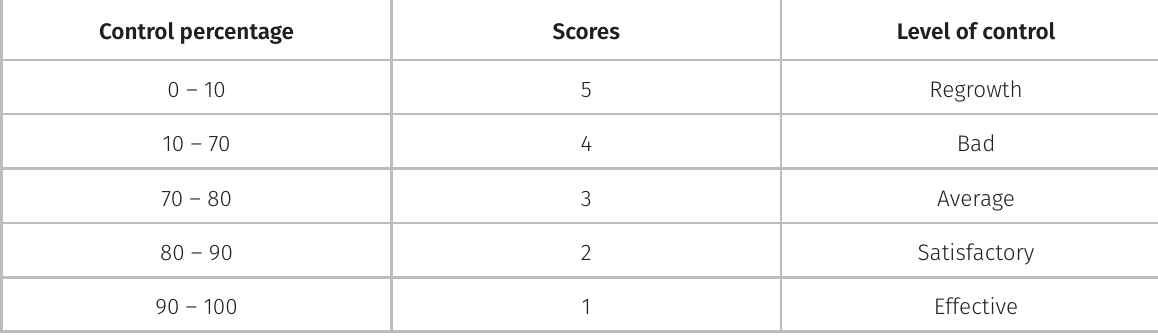
Table I. Diagrammatic scale for evaluating the control of eucalyptus